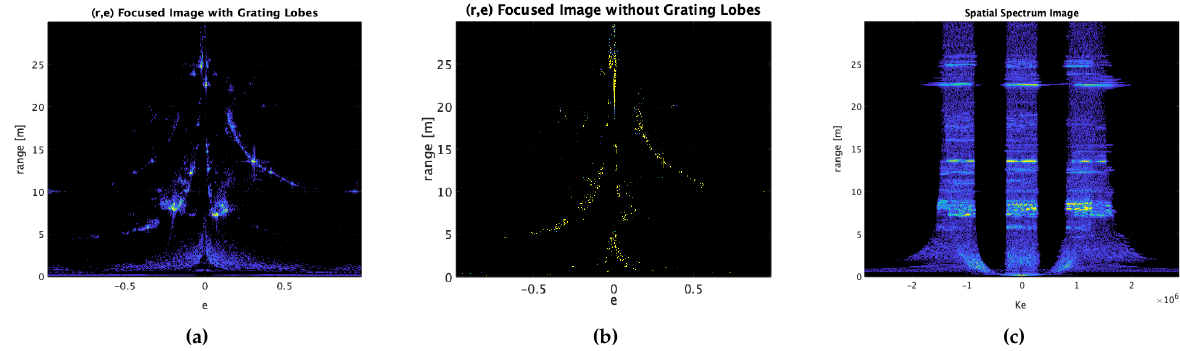
Figure 7. (a): Scene focused in the (r,e) reference system. (b): CLEAN processed image, the image is Figure 7. ( a ): Scene focused in the (r,e) reference system. ( b ): CLEAN processed image, the image is much less dense since the grating lobes have been removed. (c): Spatial spectrum image, for each much less dense since the grating lobes have been removed. ( c ): Spatial spectrum image, for each burst there is a column of data which is space invariant in the validity region of the CSA.